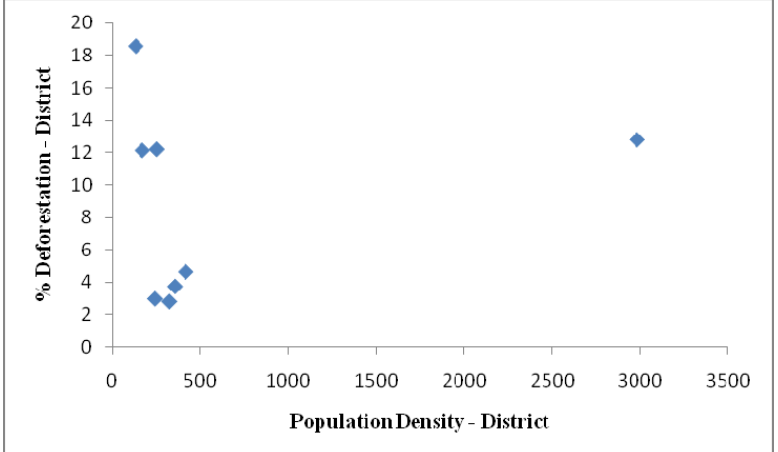
Figure 6a. Relationship between population density and the distribution of deforestation for districts.